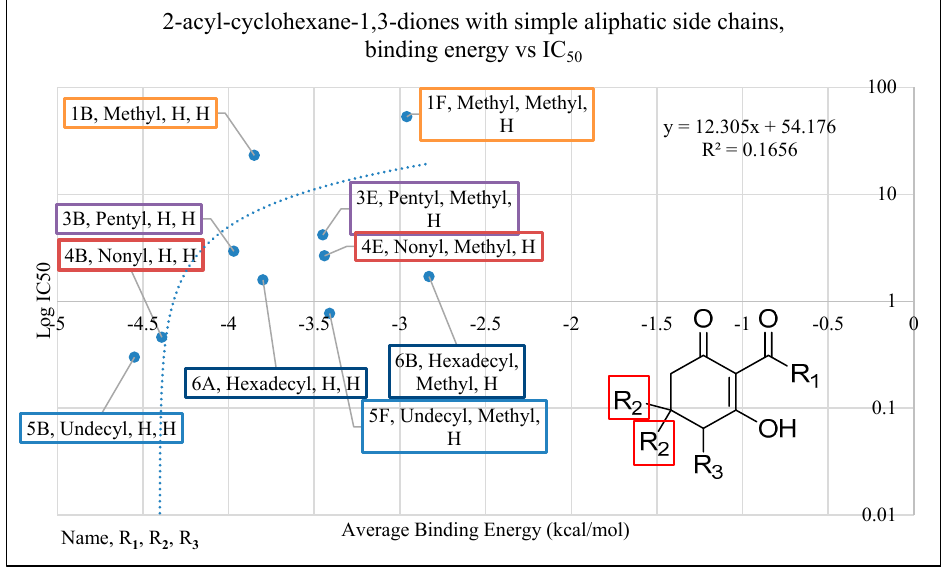
Figure 7. The relationship of binding energy and the log I 50 of a selection of 2-acyl-cyclohexane-1,3- diones with simple aliphatic side chains. Molecules are organized according to class of base structure (Grouping), seen on the bottom right. Each data label follows the pattern of “Name, Grouping, R 1 , R 2 , R 3 ”, where “R 1 , R 2 and R 3 ” refer to the functional group. Each grouping of similar tail length is shown by a colored box, with the only difference within the color selection being an addition of a head group at the R 2 location (as indicated by the red square).